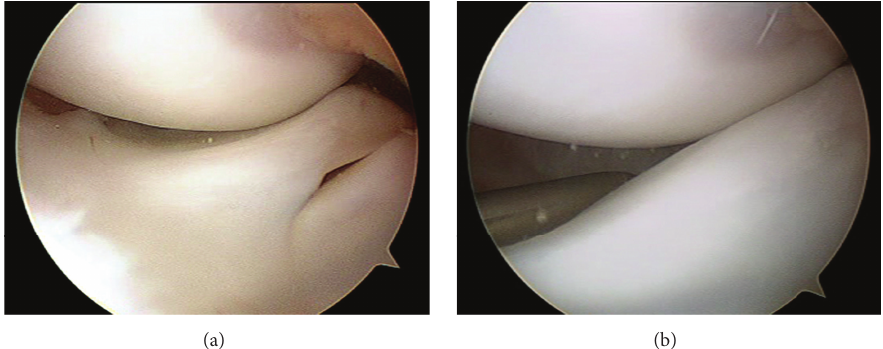
Figure 6: Arthroscopic image of the medial femorotibial compartment of the left knee from the anterolateral portal. (a) A medial discoid meniscus is shown. (b) The upper side of the meniscus is easily displaced into the intercondylar notch with a probe.